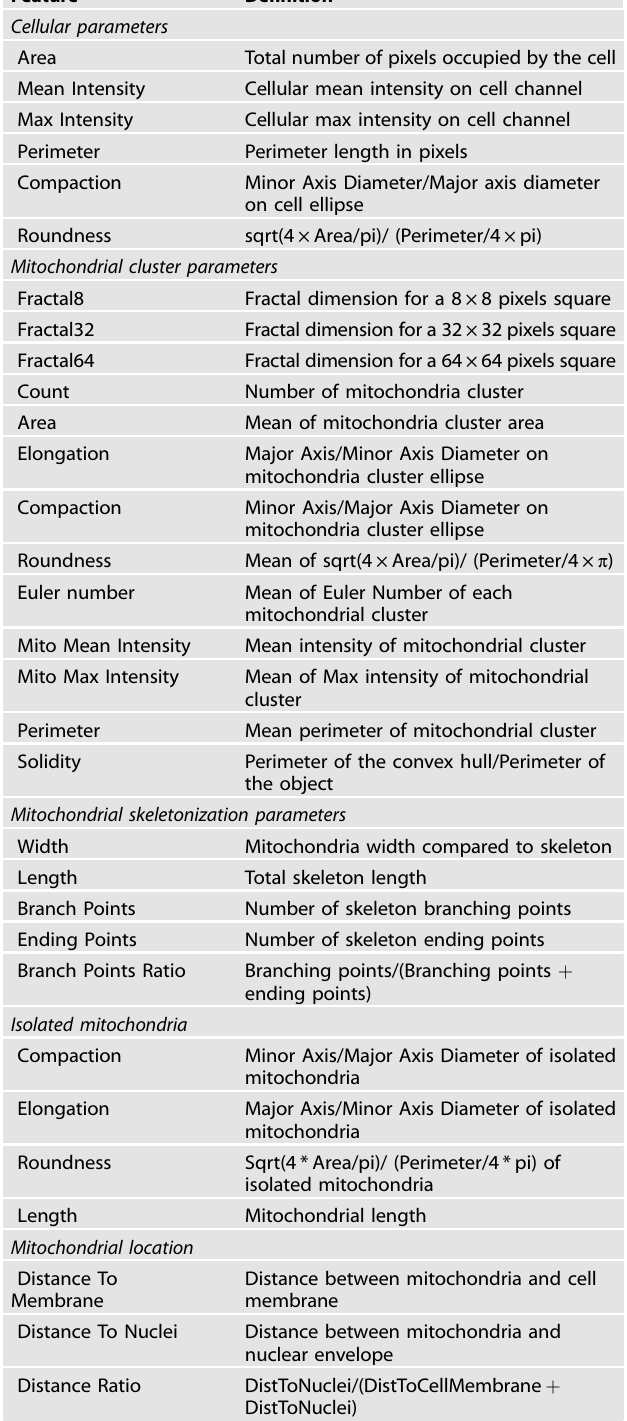
Table 2. Parameters for quantitative mitochondrial morphology